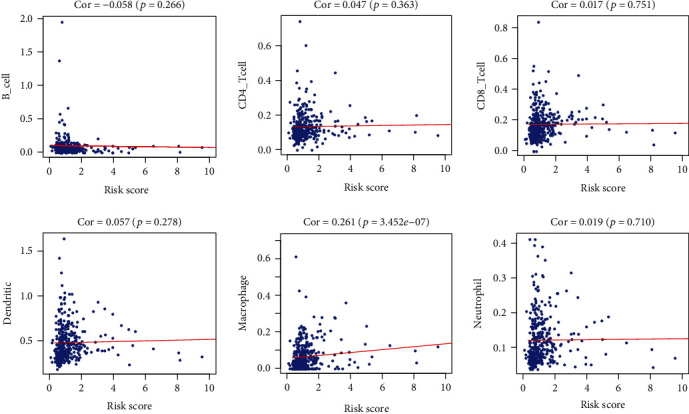
The scatter plot of the relationship between the signature and immune cells.